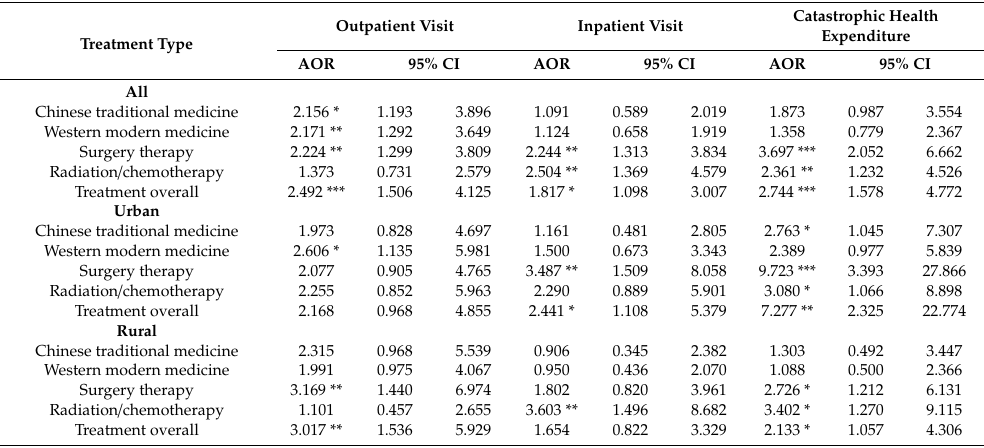
Table 4. Multivariable regression analysis of impacts of the cancer treatment on health service use and catastrophic health